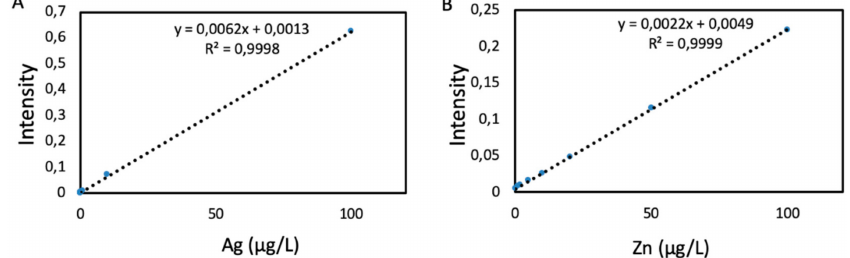
Figure 2. Calibration curve of Ag ( A ) and Zn ( B ) for the analysis of total metal content by inductively coupled plasma mass spectrometry